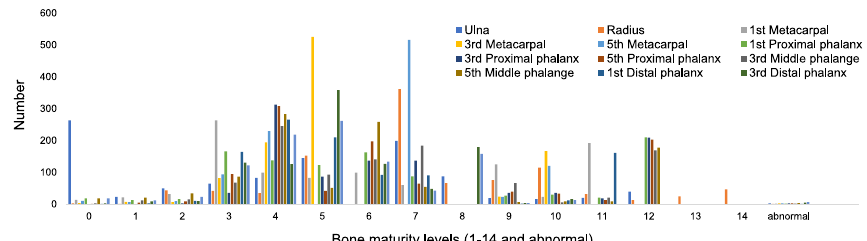
Fig. 15 Statistics of samples at different levels (totally 873 samples in the